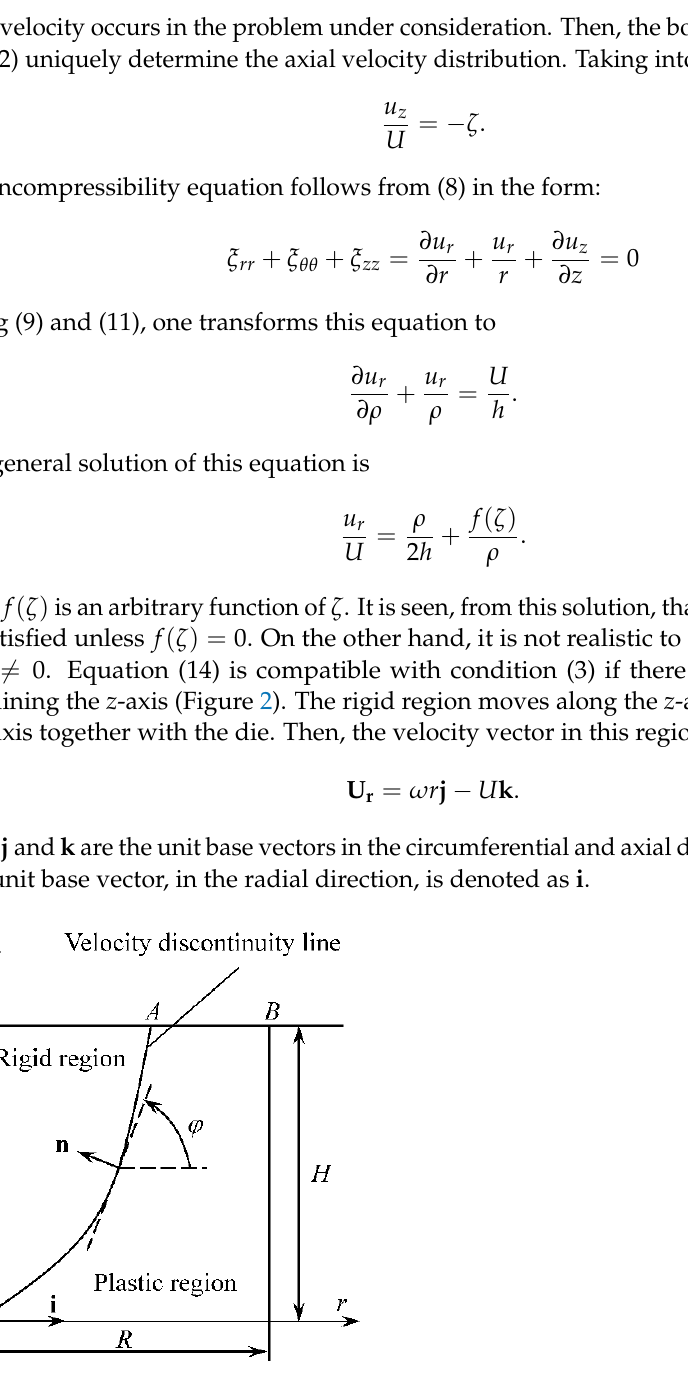
Figure 2 . General structure of the kinematically admissible velocity field. Figure 2. General structure of the kinematically admissible velocity